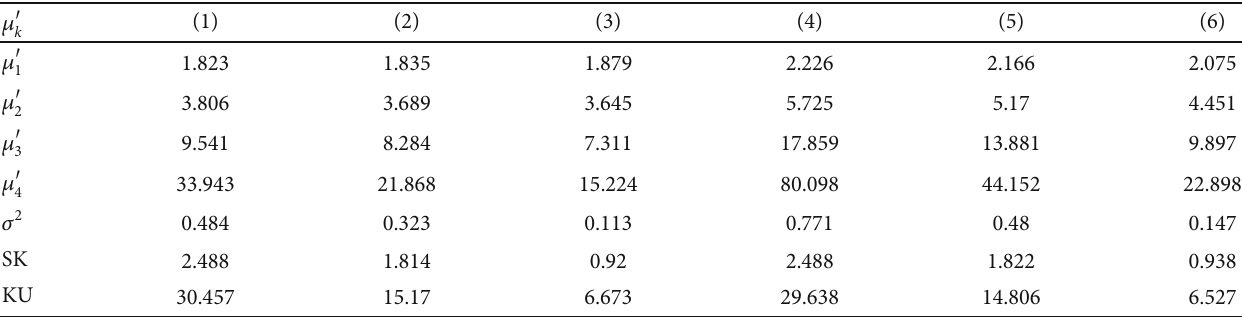
Table 1: First four moments, σ 2 , SK , and KU , of X for some choices of parameter values.